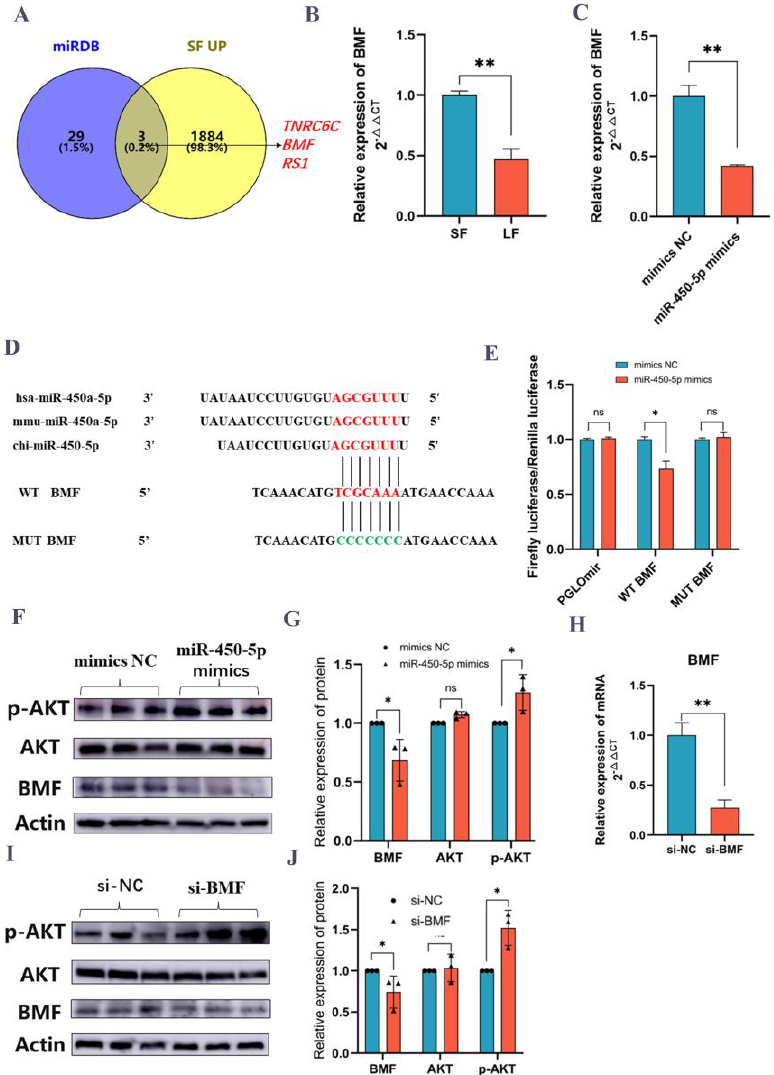
Figure 5. miR-450-5p targets BMF to activate PI3K/Akt signaling pathway ( A ): Comparison of genes upregulated in small follicles with target genes of miR-450-5p predicted by miRDB database. ( B ) BMF gene expression on small and large follicles in goats. ( C ) Expression of BMF gene after transfection with miR-450-5p. ( D ) Sequence comparison of miR-450-5p and comparison of WT-BMF and MUT-BMF target sequences. ( E ) Dual fluorescence changes of the original plasmid pGLOmir, wild plasmid WT, and mutant plasmid MUT with miR-450-5p ( F , G ) Western blot results of p-AKT, AKT, and BMF after transfection of miR-450-5p. ( H ) Expression of BMF gene after silencing BMF with siRNA. ( I , J ) Western blot results of p-AKT, AKT, and BMF silenced with siRNA. Reported experiments. Data are shown as mean ± SD values ( n = 3). * p < 0.05; ** p < 0.01was considered statistically significant. ns: not significant for statistical results.